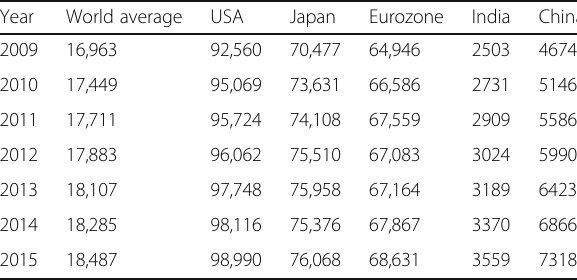
Table 2 Unit labor output (at constant prices in 2005, US$/person)